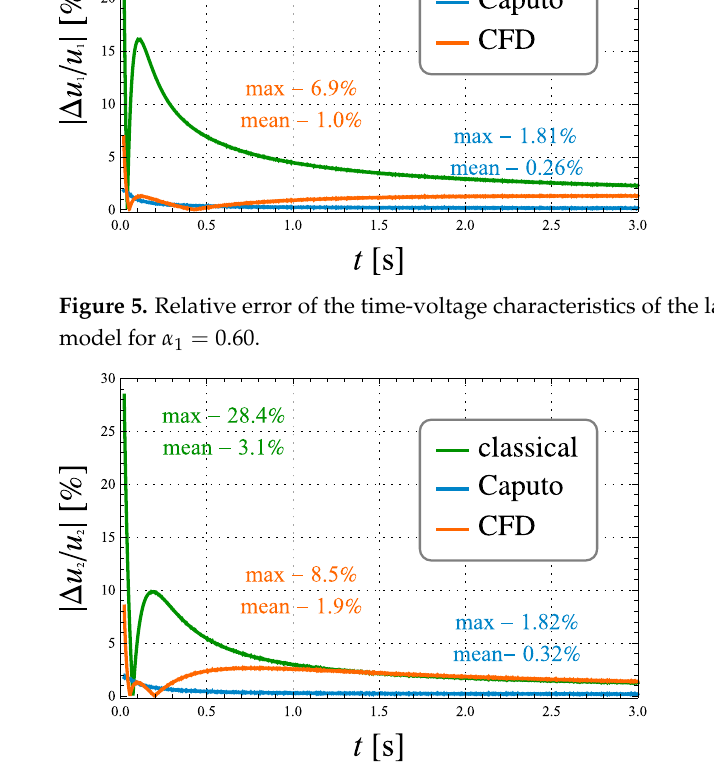
Figure 6. Relative error of the time-voltage characteristics of the ladder element depending on the model for α 2 =